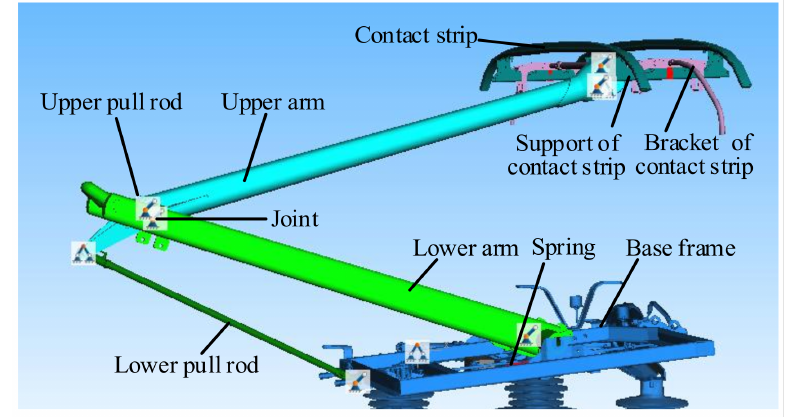
Figure 1. The pantograph dynamics model